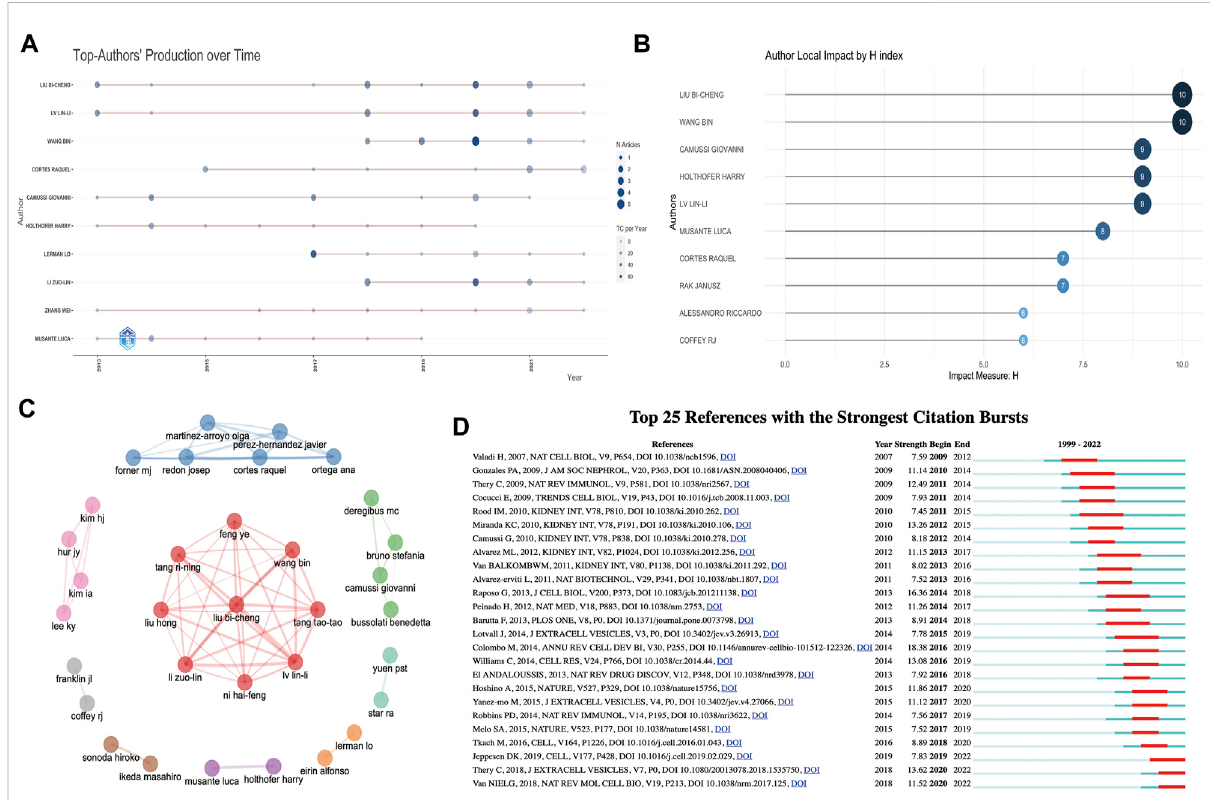
FIGURE 4 Analysis of authors and references involved in EVs in kidney disease. (A) The publication timeline for the 10 most active authors based on R. (B) AuthorlocalimpactbyH-indexbasedonR. (C) CollaborationnetworkofauthorsbasedonR. (D) Top25referenceswiththestrongestcitationbursts based on CiteSpace involved in EVs in kidney